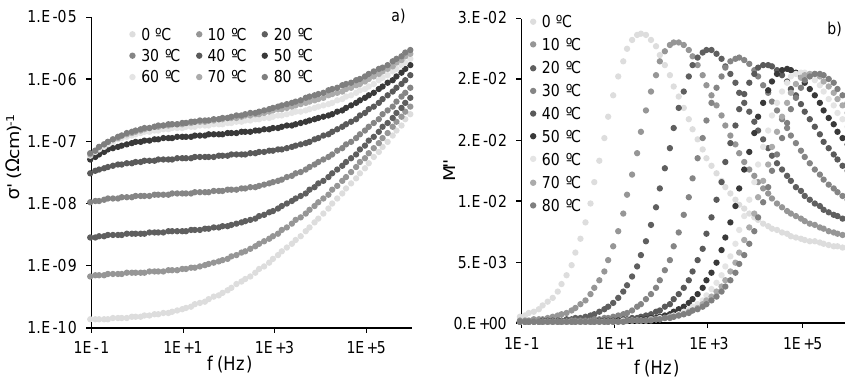
Figure 7. Isothermal spectrum between 0 and 80 °C for SA/Zn/GO composite. ( a ) Real part of the conductivity and ( b ) imaginary part of the electric modulus.